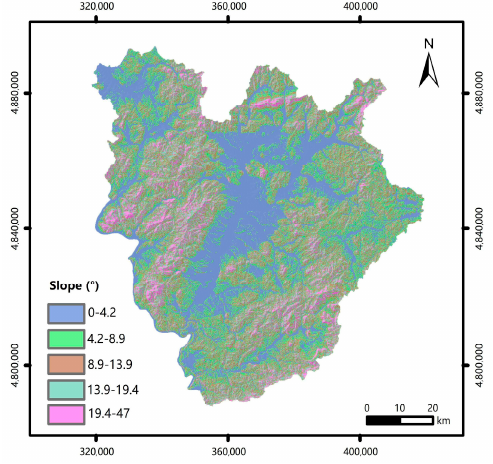
Figure 8. Slope of Jiaohe County (°).